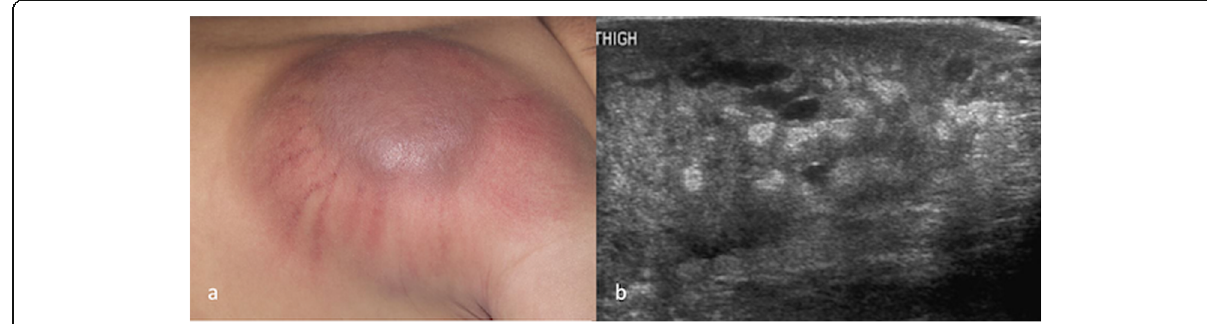
Fig. 4 a a kaposiform haemangioendothelioma (KHE) in a 1 month old female. Clinically, the lesion appears more aggressive in nature than the common infantile haemangiomas; b an ultrasound image of a KHE in another patient, showing a far more heterogenous parenchymal echotexture than that seen in